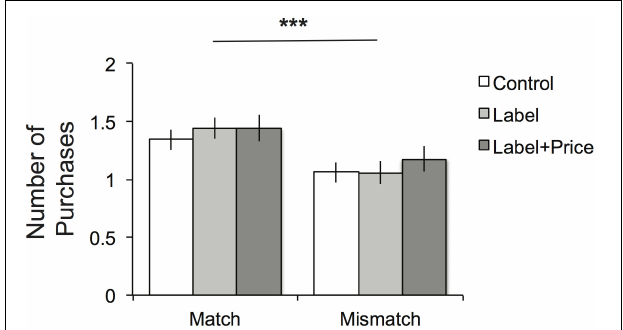
FIGURE 3 | Study 2 results. Number of purchases (“yes”) decisions made in each of the six between-subject experimental conditions. ***p < 0.001.